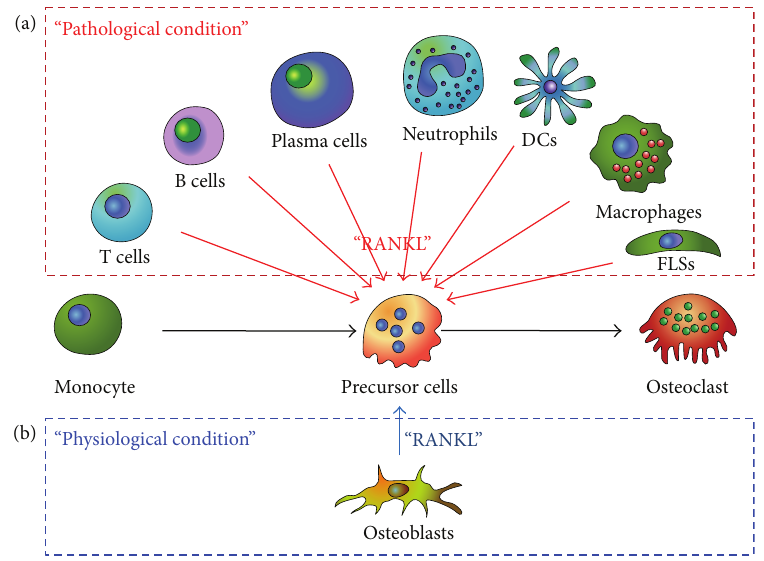
Figure 3: (a) Monocytes are differentiated into mature osteoclasts by the aid of RANKL. In pathological conditions such as inflammation, cancer, and hypermetabolism, various cells extraordinarily provide RANKL to the monocytes, resulting in overweighed osteoclastogenesis. In this condition, the osteoclasts outnumber the osteoblasts, disrupting the bone homeostasis. Bone erosion or osteoporosis is the major outcome of disrupted homeostasis. (b) In normal physiological conditions, a few cells, predominantly osteoblasts, express RANKL. A similar number of osteoclasts and osteoblasts maintain the bone mass by homeostatic